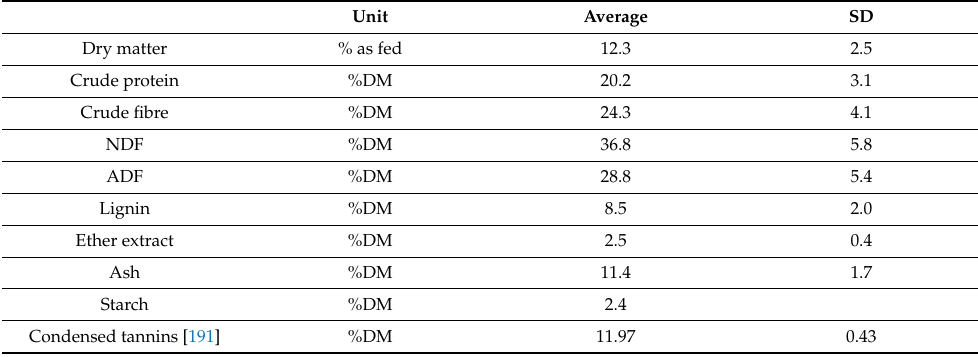
Table 6. Nutritional value of Hedysarum coronarium L.